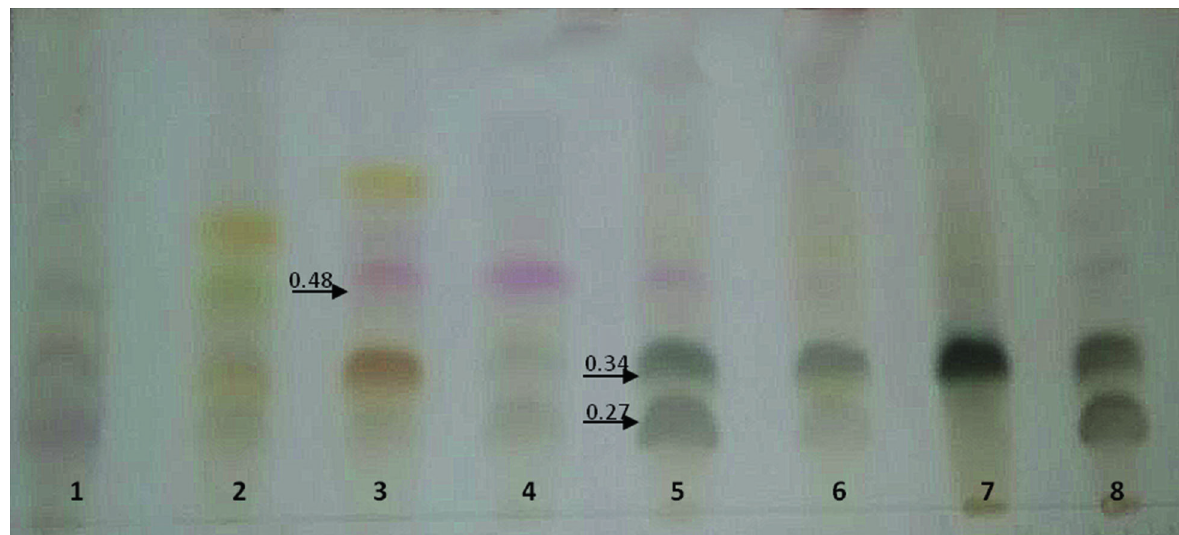
Figure 2 - TLC plate for the identifi cation of saponins in the extracts from in vitro derived materials of four Passifl ora species. 1-4 Leaves of P. alata (1), P. pohlii (2), P. suberosa (3), P. foetida (4). 5-8 Roots of P. alata (5), P. pohlii (6), P. suberosa (7), P. foetida :AcOH:MeOH:H O (60:32:12:8, v/v). Visualization: anisaldehyde-H (8). Mobile phase: CHCl 3 2